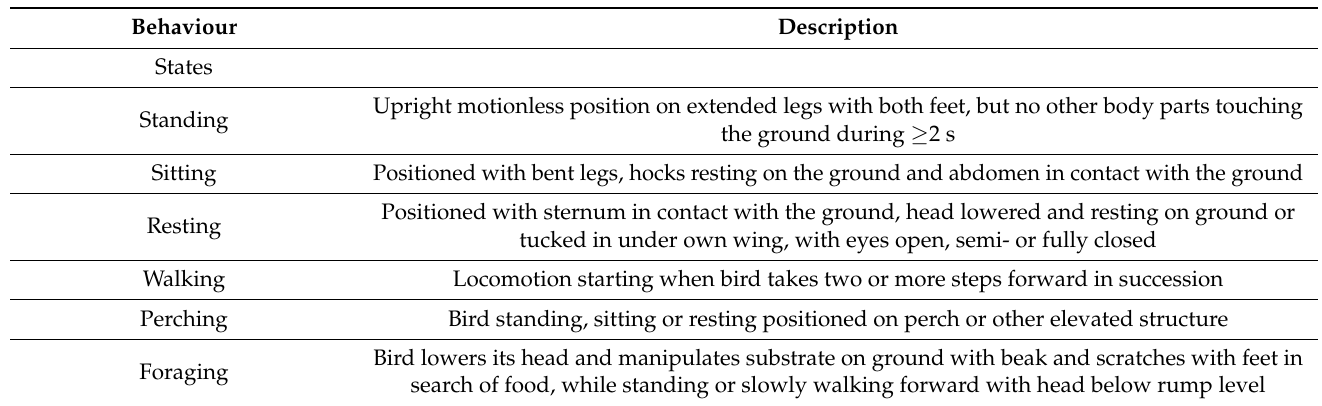
Table 1. Ethogram used for behavioural observations on Swedish organic broiler farms (modified from Rodriguez- Aurrekoetxea et al. (2015) [26] and Ventura et al. (2012) [30]). Behaviour Description States Upright motionless position on extended legs with both feet, but no other body parts touching Standing the ground during ≥ 2 s Sitting Positioned with bent legs, hocks resting on the ground and abdomen in contact with the ground Positioned with sternum in contact with the ground, head lowered and resting on ground or Resting tucked in under own wing, with eyes open, semi- or fully closed Walking Locomotion starting when bird takes two or more steps forward in succession Perching Bird standing, sitting or resting positioned on perch or other elevated structure Bird lowers its head and manipulates substrate on ground with beak and scratches with feet in Foraging search of food, while standing or slowly walking forward with head below rump